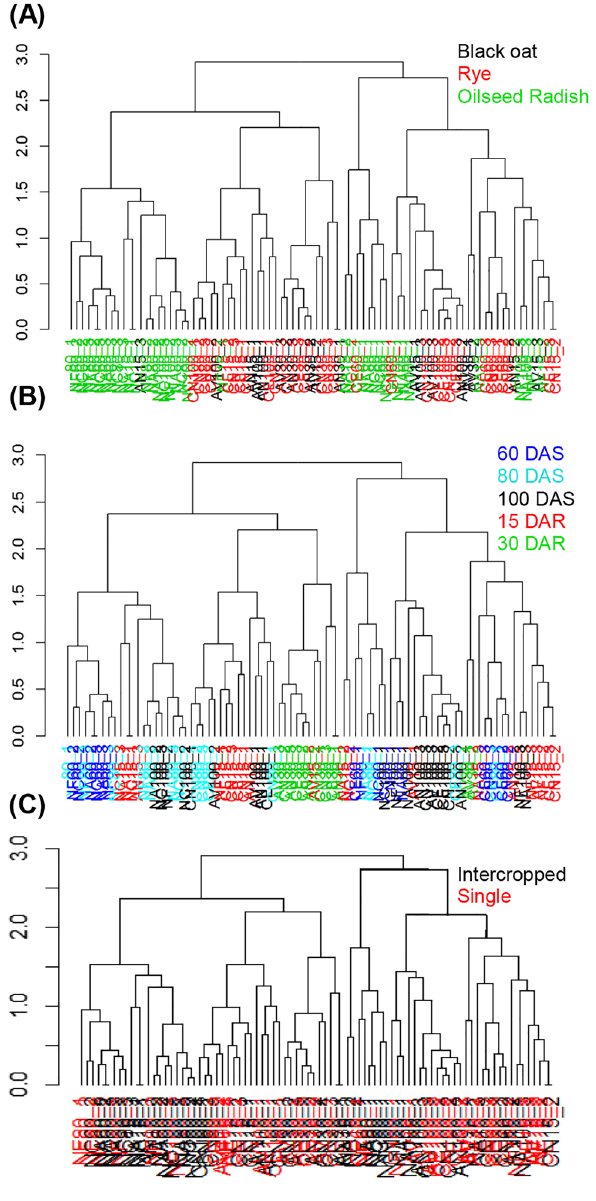
Figure4: DendrogramsofUV–visspectraintheregionof 200–400 nm after hierarchical clustering analysis using the Euclidean distance. Colors indicate plant species (A), periodofsampling(daysaftersowing-DASanddaysafter rolling-DAR) (B) and crop management system